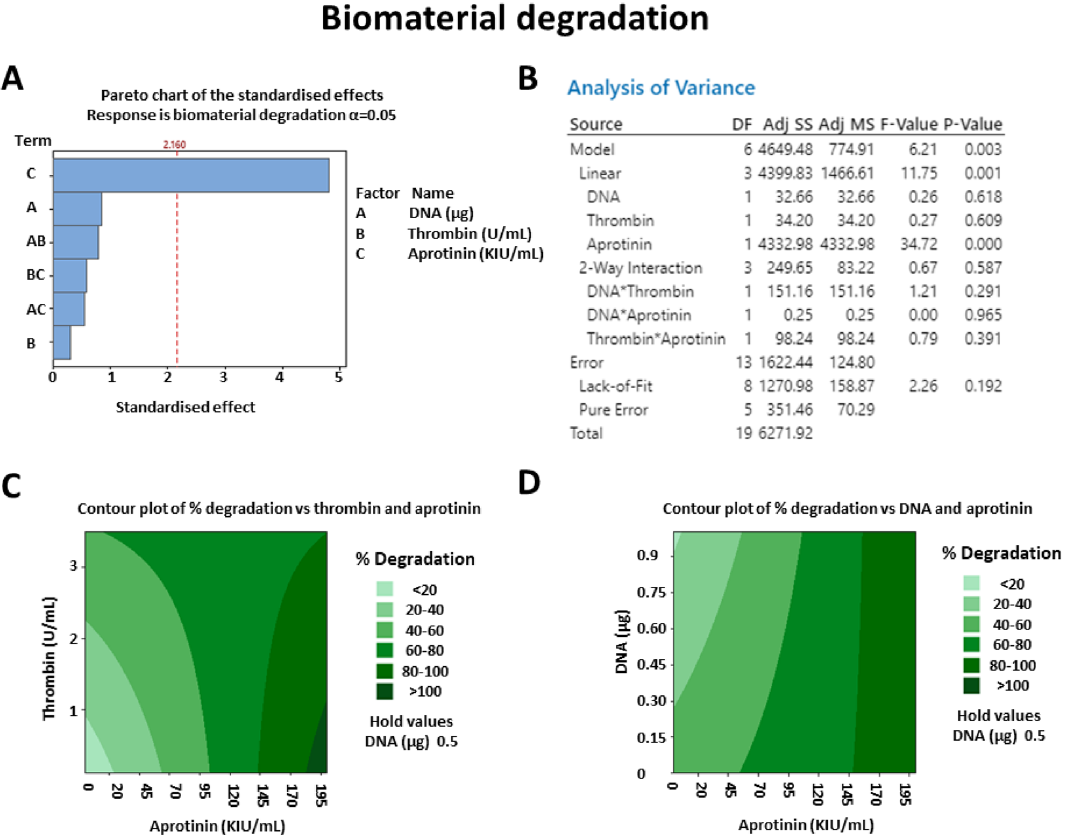
Figure 8. Characterisation of variables affecting biomaterial degradation through design of experiment. A response surface design was used to determine whether aprotinin, thrombin or DNA modulated hydrogels stability. As shown in the Pareto chart ( A ) and in the ANOVA table ( B ), aprotinin was the only factor significantly affecting biomaterial degradation. Surface contour plots show how biomaterial degradation varied at different concentrations of aprotinin and thrombin ( C ) or at different concentrations of aprotinin and DNA ( D ). N =